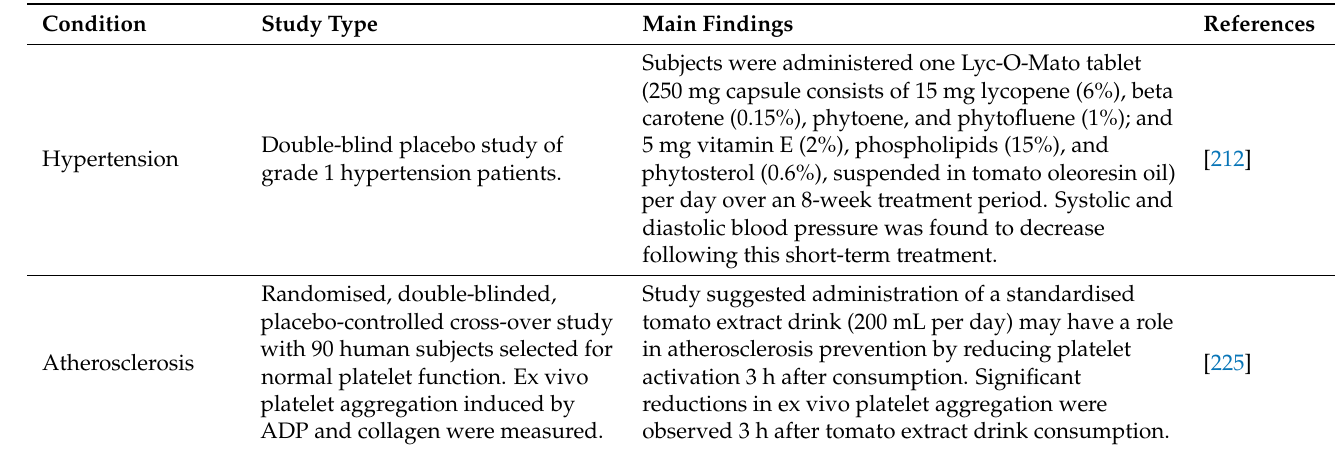
Table 3. Main findings of the effects of tomatoes on conditions detailed as part of this